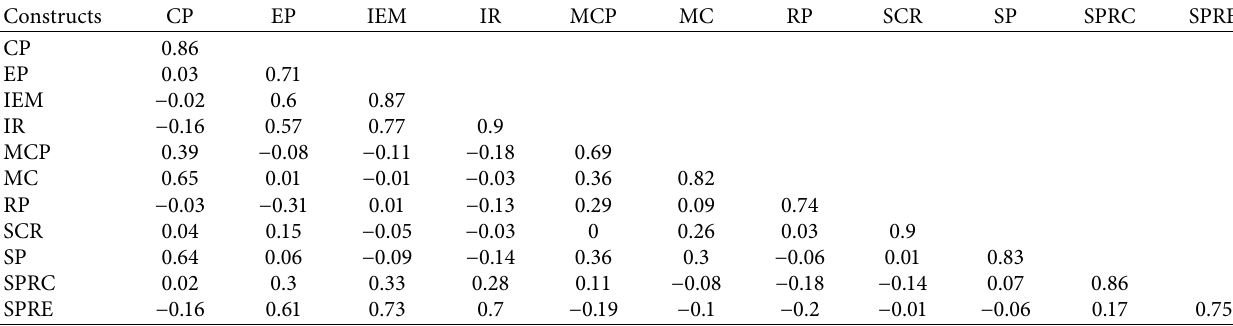
Table 8: Discriminant validity analysis (Fornell and Llacker’s criterion).